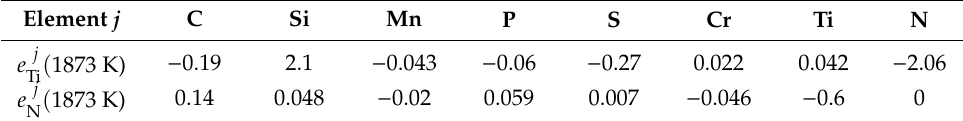
Table 3. The interaction coefficients of element j to Ti and N at 1873 K.